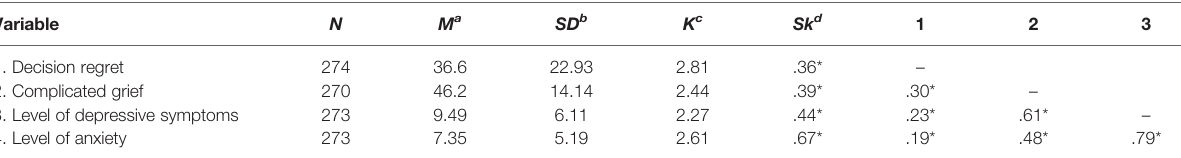
TABLE 2 | Descriptive statistics and pearson product-moment correlations for study variables. Variable